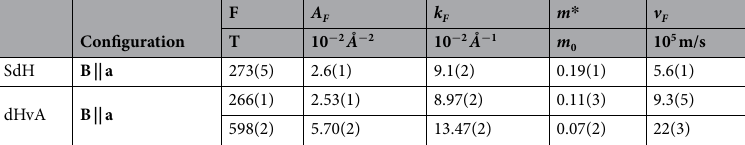
Table 1. Fermi surface parameters extracted from SdH and dHvA